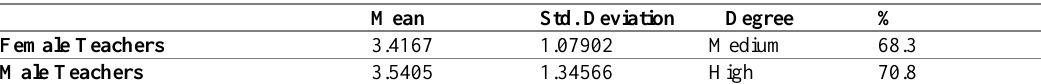
Table 3: Usefulness for